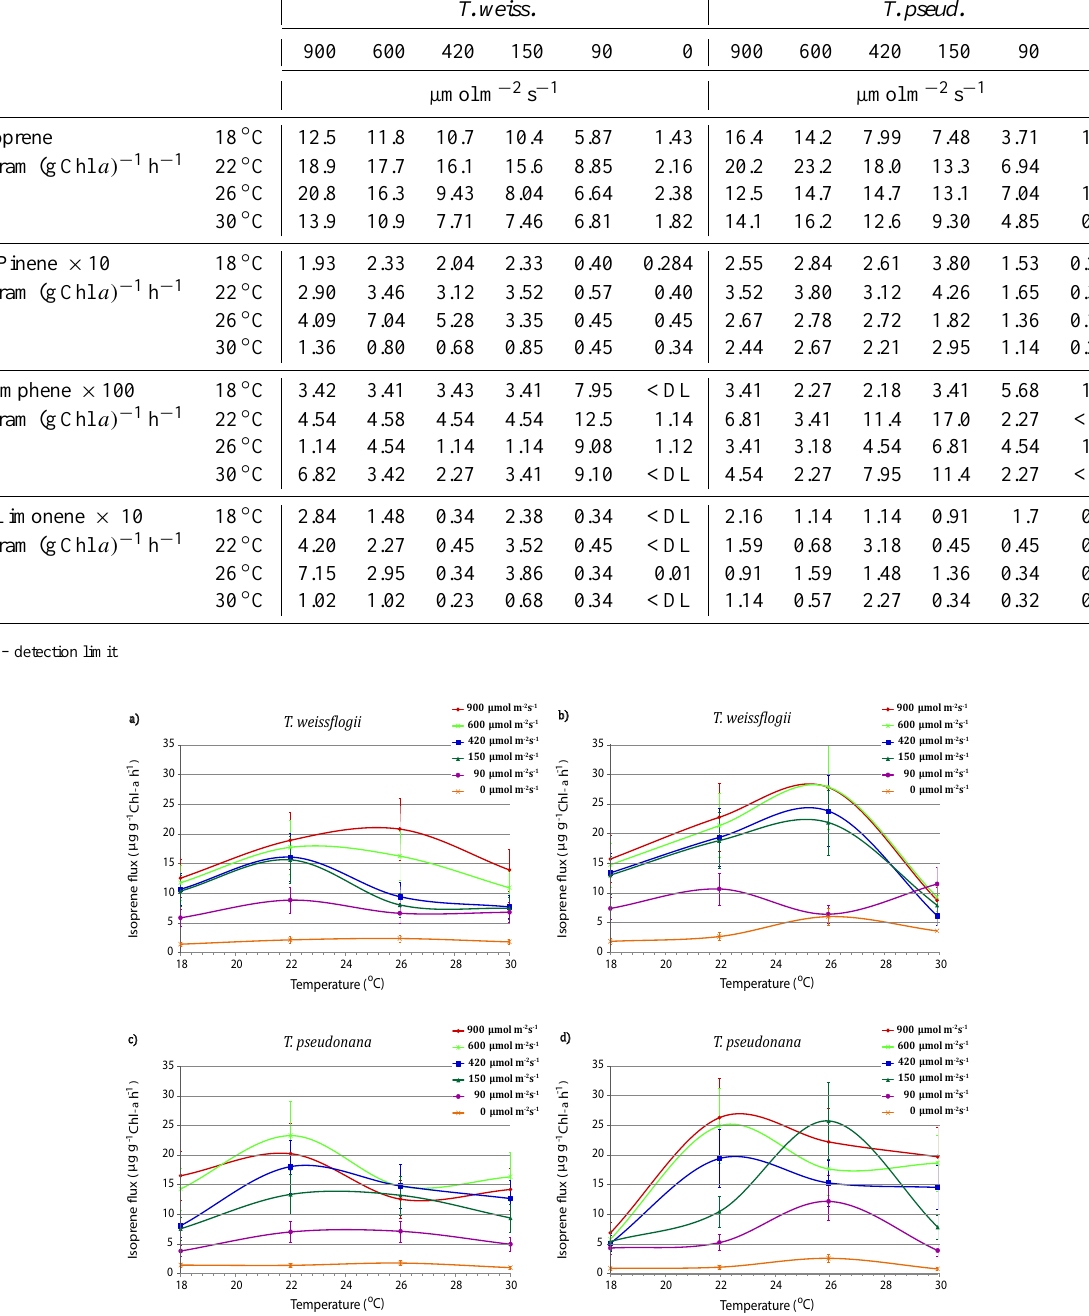
Figure 4. The 12h averaged isoprene production rates (µg (gChl a ) − 1 h − 1 ) for the first (left column) and second (right column) light cycles as a function of temperature. Error bars denote the RSD Total value listed in Table